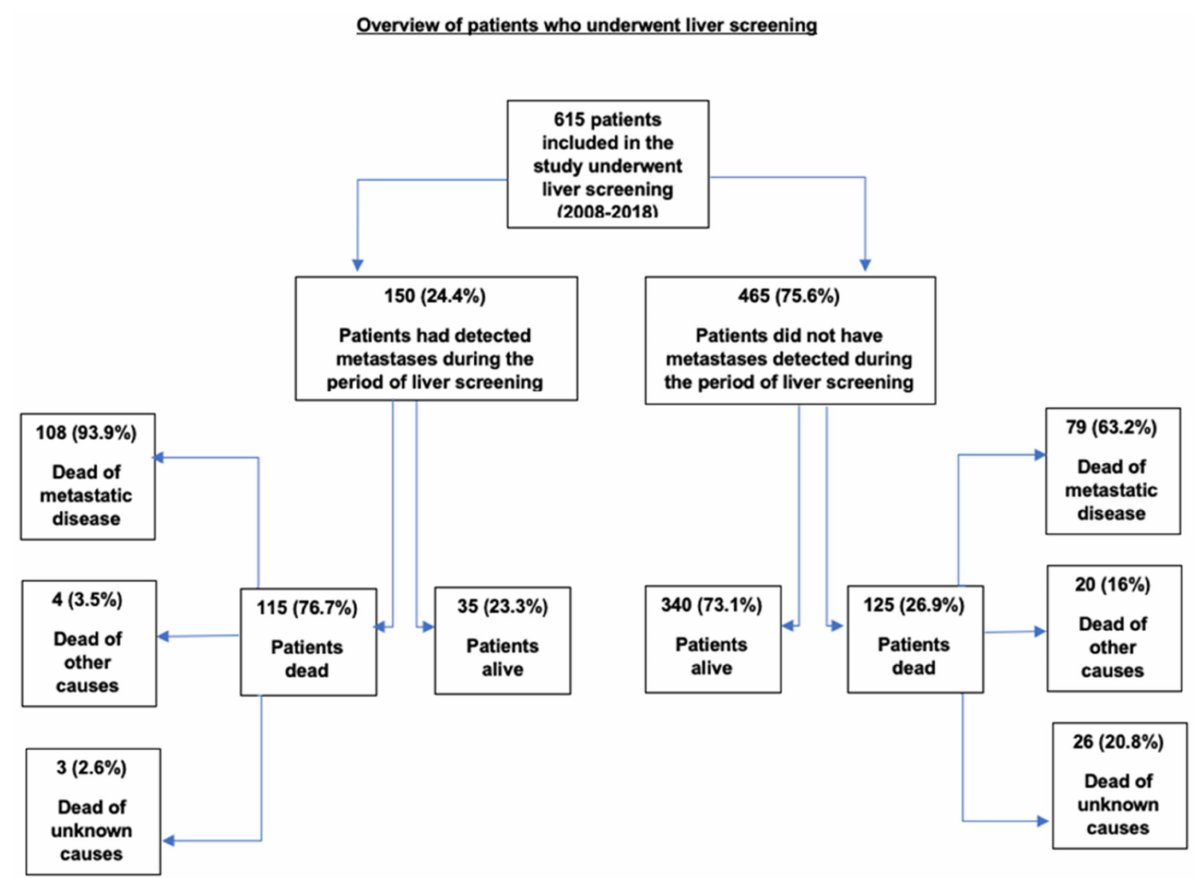
Figure 1. Overview of 615 patients who underwent liver screening according to the detection of metastases, outcome and cause of